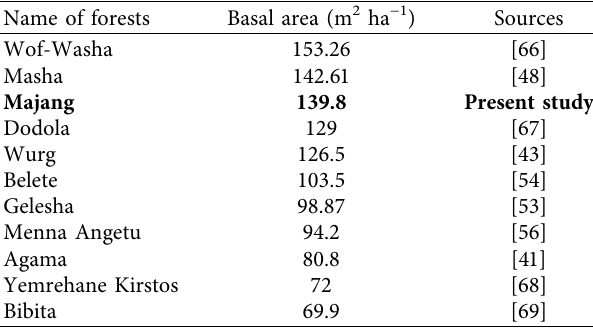
Table 17: Comparison basal area per hectare of Majang biosphere reserves natural forest with other ten moist Afromontane forests in